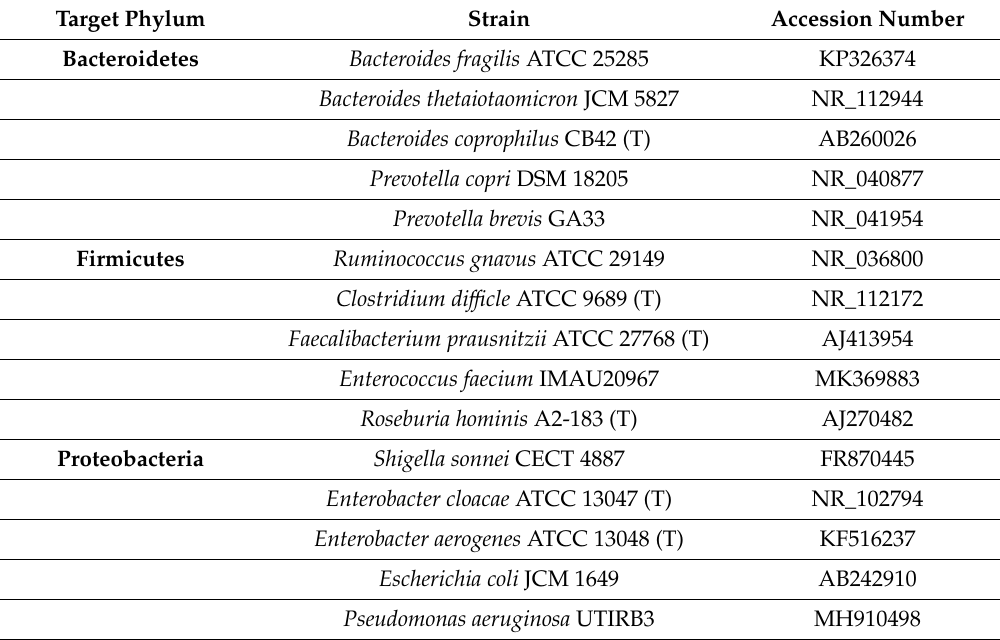
Table 9. Bacterial strains of di ff erent phyla used to design phylum-specific primer-probe sets. Target